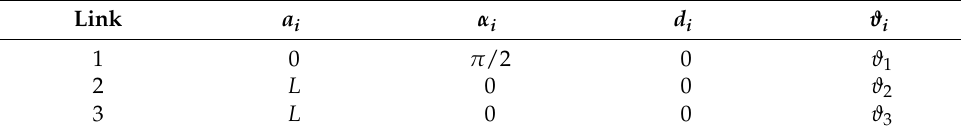
Figure 1. Kinematic scheme reporting Denavit-Hartenberg parameters. Table 1. Rigid Robot Denavit-Hartenberg